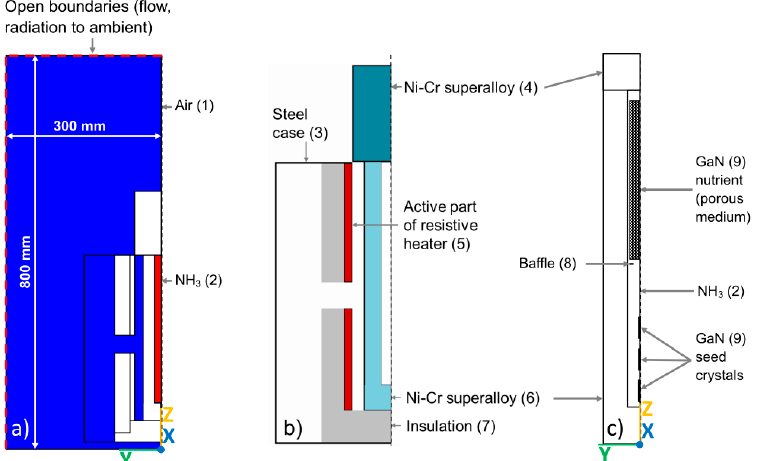
Figure 1. Geometry and materials used in simulation of temperature distribution and fluid flow. ( a ) Domain of type A cases, with fluid regions indicated by color (blue: Air, red: Supercritical NH 3 ). The distance between bottom domain boundary and bottom of the furnace is 15 mm, ( b ) Close-up of geometry showing the solid materials. The red areas correspond to the two heaters. ( c ) Simulation domain, geometry, and materials for cases of type B and C, containing only the autoclave and its interior. X, Y, and Z represent the positive directions of the cartesian coordinate system used to describe the geometry in the simulation. Gravity acts in the negative Z direction. An overview of the materials used is given in Table 1. The numbers in brackets are used in subsequent tables as well as Figure 1 to refer to the materials. Table 1. Overview of materials used in simulation of temperature distribution and fluid flow.